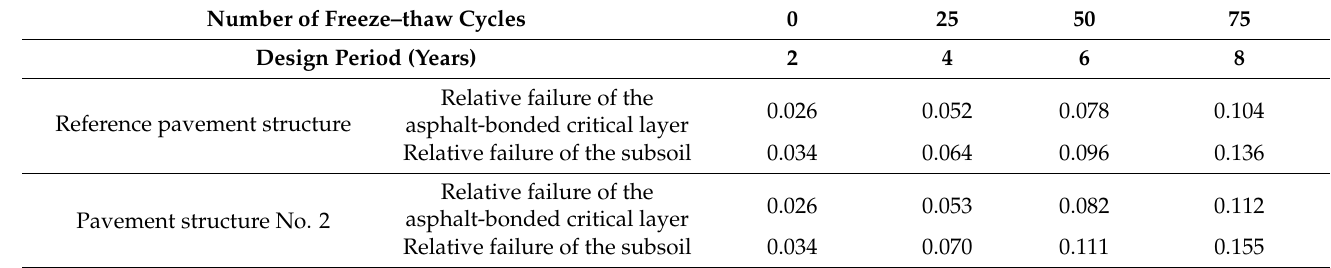
Table 7. Assessment of pavement structure No. 2 and relative failure of D cd (change in the modulus of stiffness of wearing course due to the number of freeze–thaw